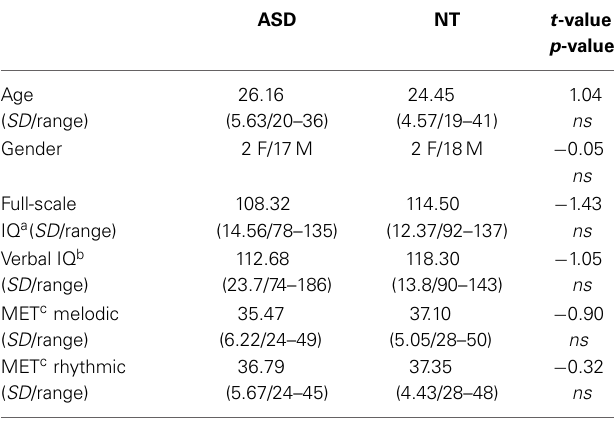
Table 1 | Participant